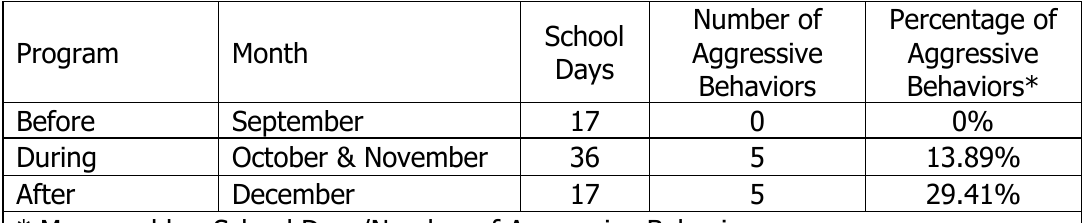
Instances of Aggressive Behaviors as reported by the